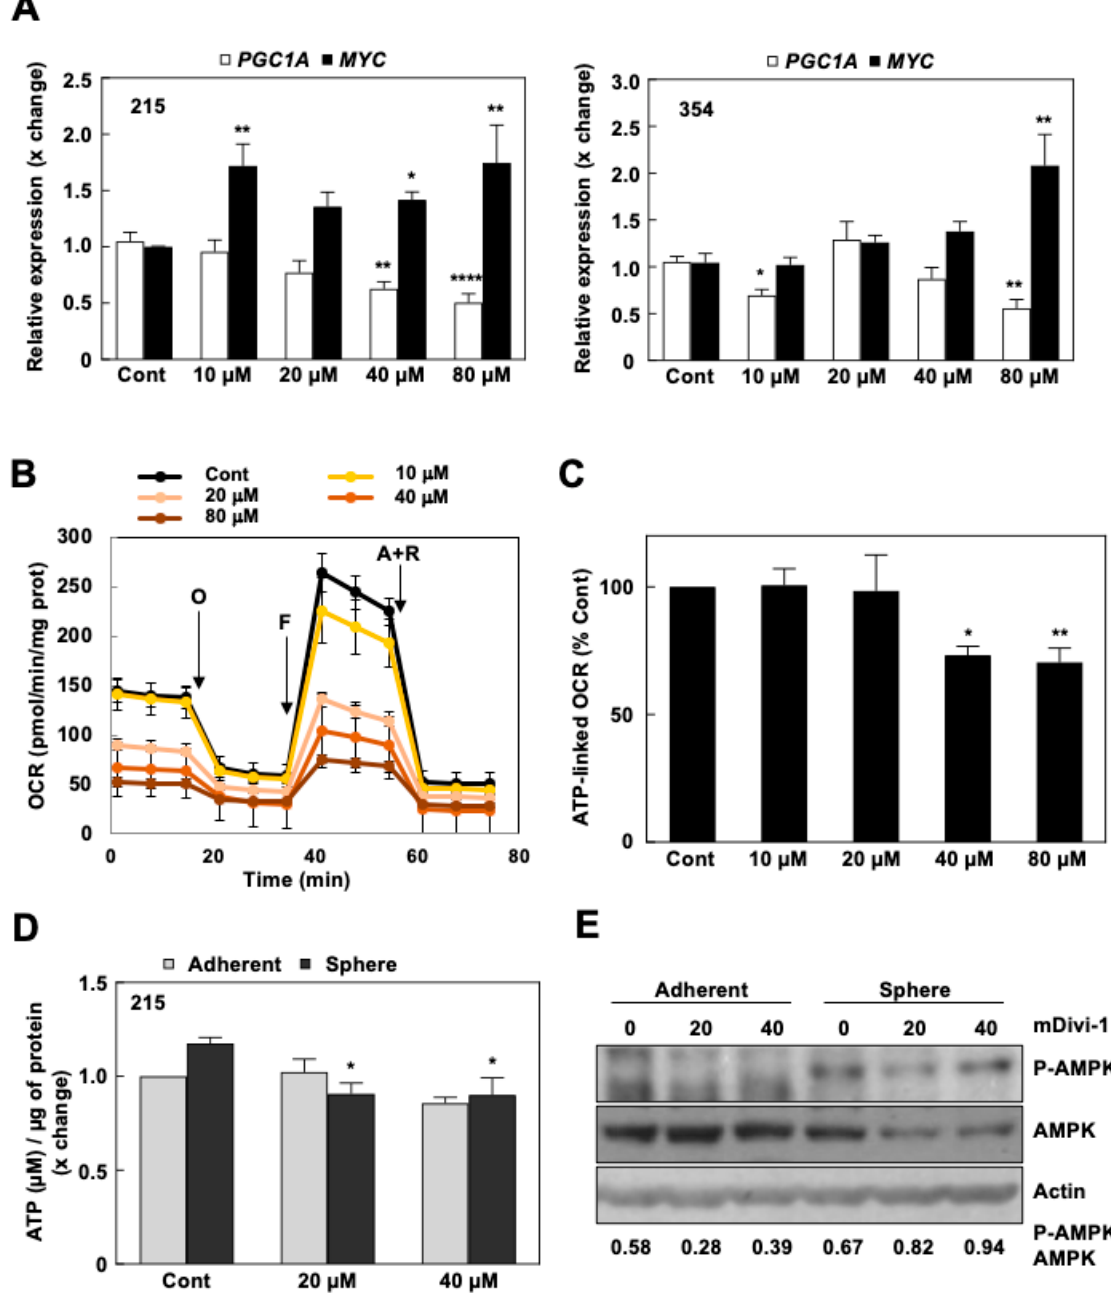
Figure 4. mDivi-1 treatment impairs mitochondrial respiration, provoking energy crisis in pancreatic CSCs. ( A ) Relative PGC1A and MYC gene expression in 215 and 354 cells in response to mDivi-1 treatment for 72 h ( n = 9–16). HPRT expression was used as endogenous control. ( B ) Representative Mito Stress Test experiment for 253 cells treated for 48 h with mDivi-1, showing changes in the Oxygen Consumption Rate (OCR) in response to sequential treatments with Oligomycin (O), FCCP (F) and Antimycin A + Rotenone (A+R). ( C ) ATP-linked respiration measured after 48 h of mDivi-1 treatment. Pooled data for 215, 253, and 354 PDAC cells ( n = 8–12). ( D ) Quantification of ATP content/µg protein in sphere cultures of 215 cells after 48 h of mDivi-1 treatment ( n = 4). ( E ) Western blot for AMPK and p -AMPK expression in 253 cells cultured in either adherent or sphere conditions after 72 h of mDivi-1 treatment. Numbers below represent the densitometric analyses of the normalized ratio of P-AMPK on AMPK. β -actin was used as a loading control. * p < 0.05, ** p < 0.01, **** p < 0.0001; Kruskal–Wallis with Dunn’s post-test ( A ); ANOVA with Bonferroni post-test ( C , D ). Data shown in the figure represent averages ± S.E.M. Controls set as 1 or 100% for fold changes.